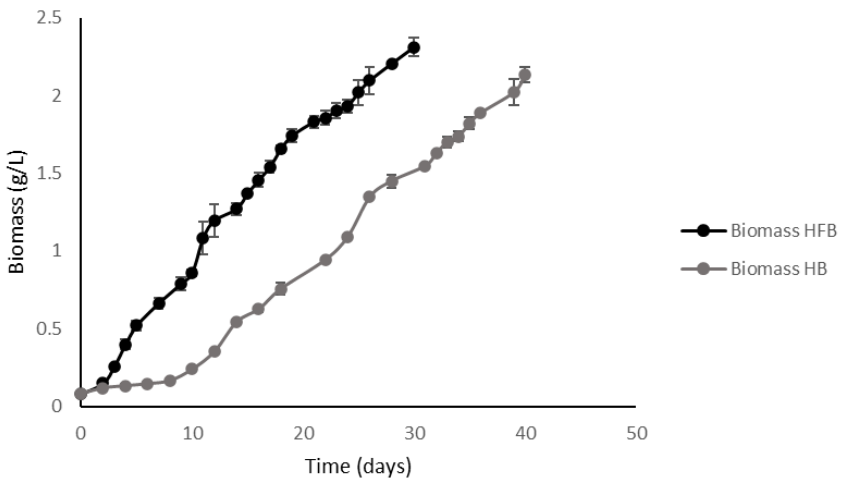
Figure 5. Biomass accumulation in fed-batch and batch culture systems. The figure shows the bio- mass accumulation kinetics (g/L) as a function of time for cultures in batch mode and fed-batch mode under the same culture medium conditions. Cultures were stopped 4 days after the nitrogen depletion. HB: high-density batch. HFB: high-density